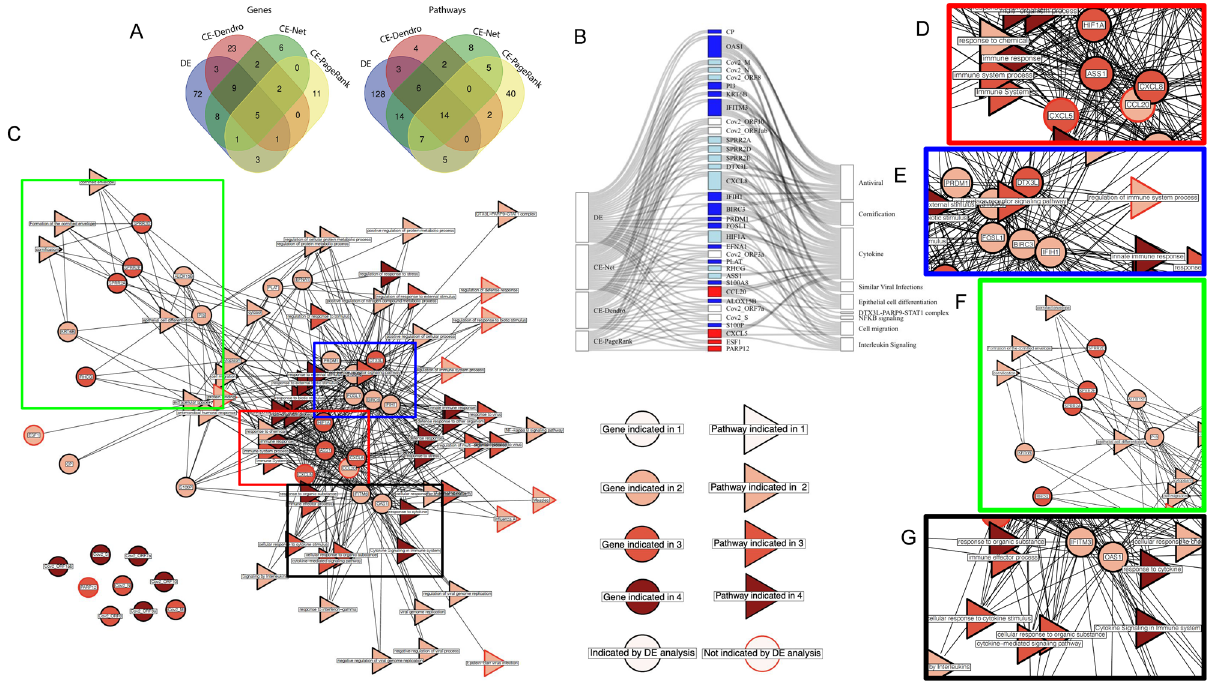
Figure 4. ( A ) The overlap in gene and pathway results indicated by DE, CE-Dendro, CE-Net, and CE-PageRank views by venn diagram. ( B ) Sankey diagram showing genes found by at least two of four views and pathway themes in which they participate. Genes are colored based on the views that they are found in, white, light blue, and dark blue indicate that DE and 1, 2, or 3 other CE views, respectively, and red for a gene that is not found by DE, but was by a CE view. Genes are connected to themes created from a list of gProfiler pathways (Suppl. Table 1). ( C ) The consensus network for the cross-analysis overlaps between these four views results in four gene modules. Genes are displayed as circular nodes and pathways are displayed as triangular nodes. Nodes with red borders represent results that did not manifest in traditional differential expression analysis, and, therefore, demonstrate the power of the dRAP pipeline to not only highlight important findings in DE analysis, but to also reveal previously hidden signatures. ( D ) The red module ( CXCL5 , CXCL8 , CCL20 , ASS1 , HIF1A ) is indicative of chemokine activity, cytokines, and a lipopolysaccharide response. ( E ) The blue module ( IFIH1 , PRDM1 , BIRC3 , FOSL1 , DTX3L , S100A8 ) indicates an innate immune response. ( F ) The lime